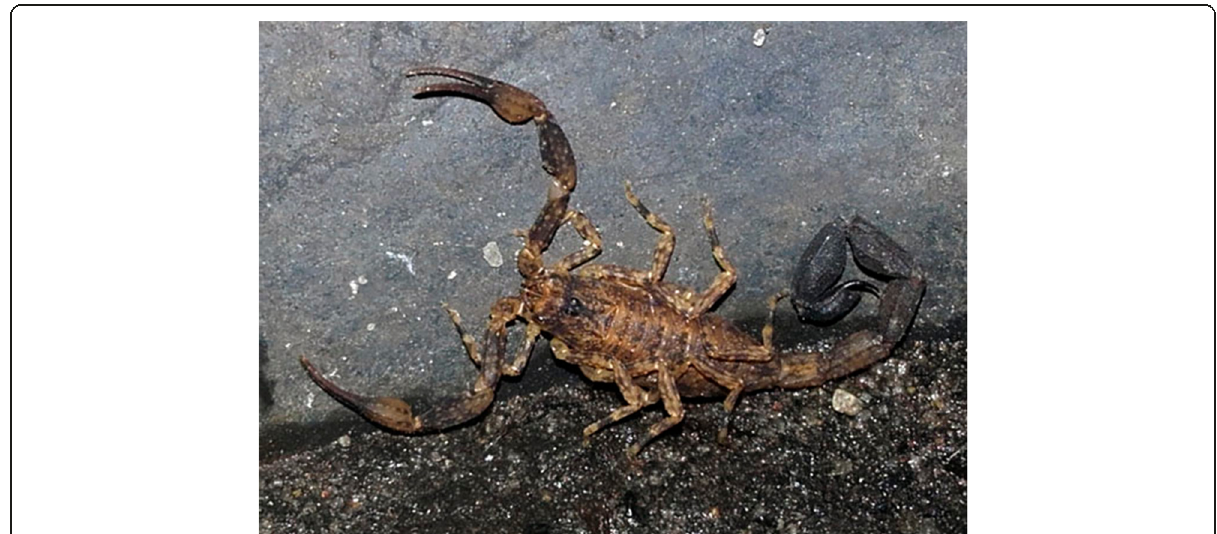
Fig. 2 Tityus silvestris collected in the eastern Brazilian